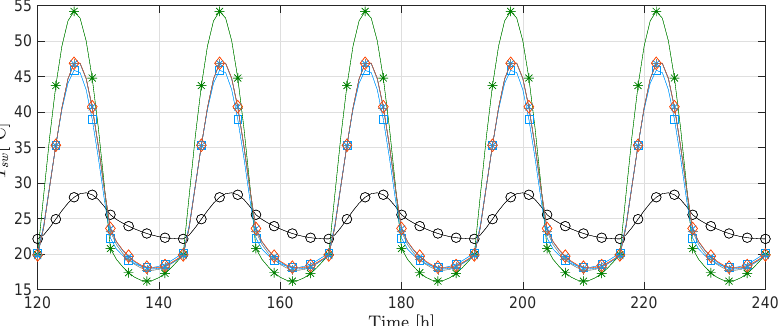
Figure 15. Heat flux distribution over time at the interior surface of the ICB system: ( ∗ ) no canopy, e = 0.10 m; ( ◦ ) e = 0.00 m; ( (cid:3) ) e = 0.05 m; (+) e = 0.10 m; ( × ) e = 0.15 m; ( (cid:5) ) e = 0.20 m.